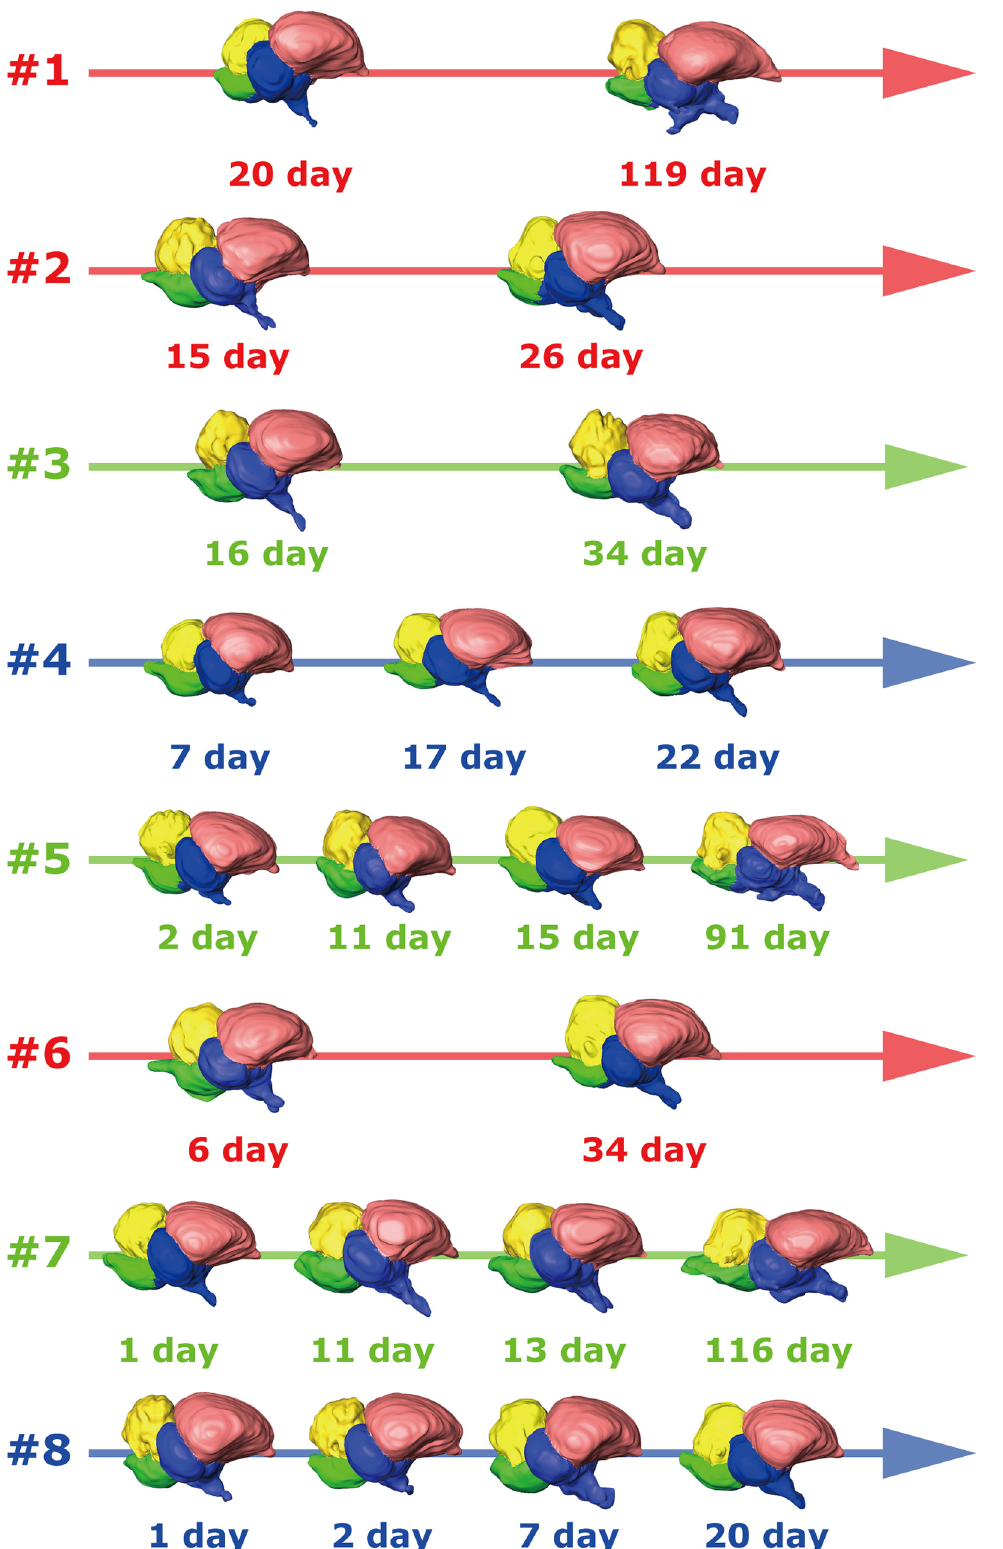
Fig 3. Ontogenetic shape variations (#1 to #8) (not to scale).